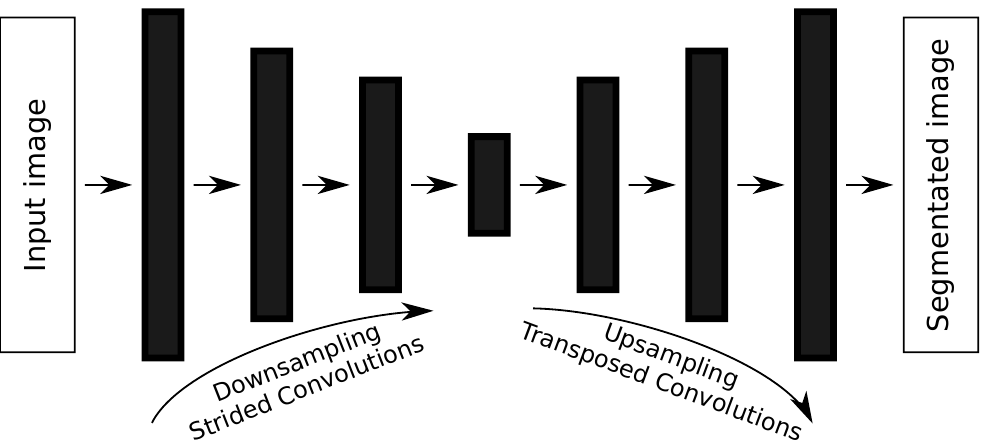
Figure 1. Example of a traditional DNN topology used for semantic